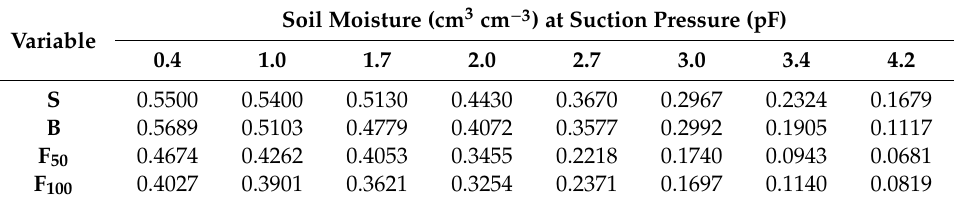
Table 2. Results of measurements of water retention curves.